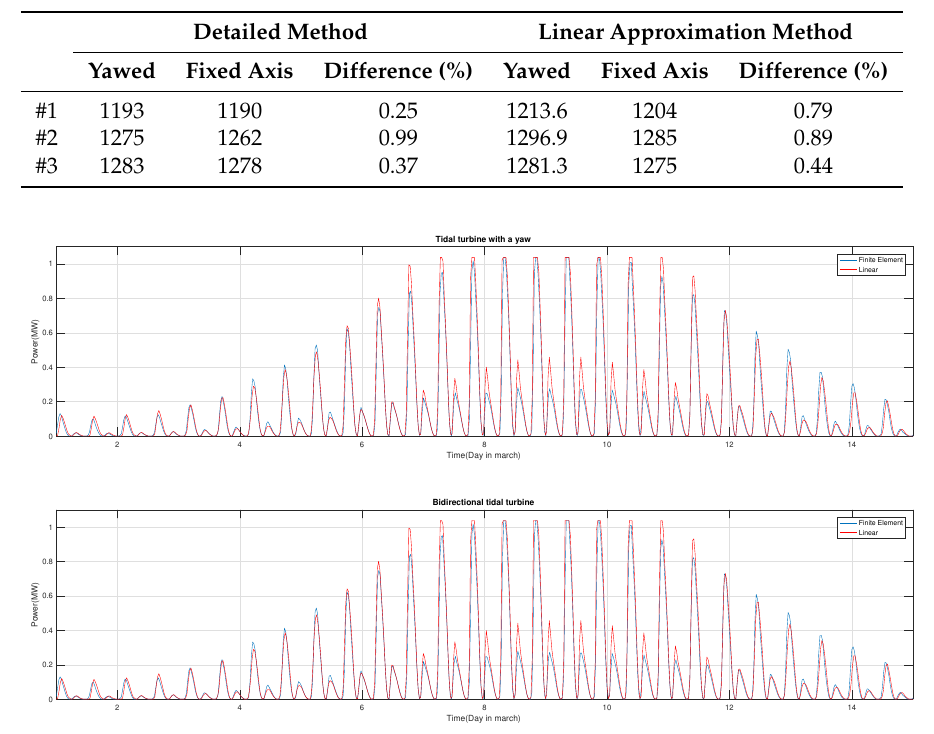
Table 3. Estimation of extracted energy at locations #1, #2 and #3 with the detailed and linear approximation methods, for yawed and fixed axis devices, during the year 2016 (results are expressed in MWh).